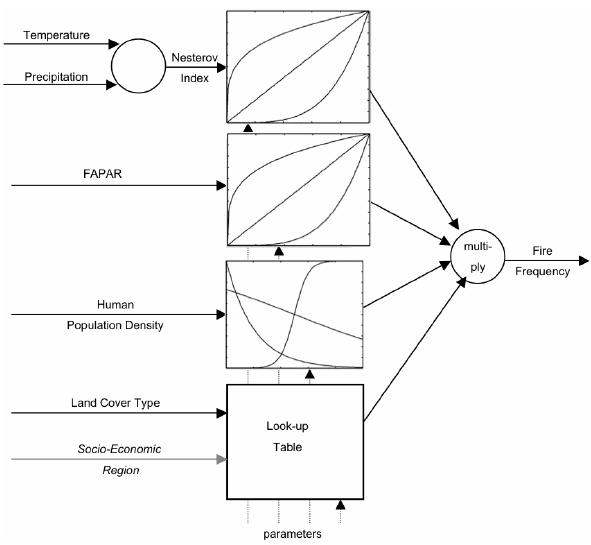
Fig. 1. Schematic representing flows of information (solid lines) for the model of fire frequency. Square boxes show several examples for non-linear dependences that are possible depending on choice of control parameters (dotted lines). Circles represent further complex (Nesterov Index) or simple (“multiply”) arithmetic operations.